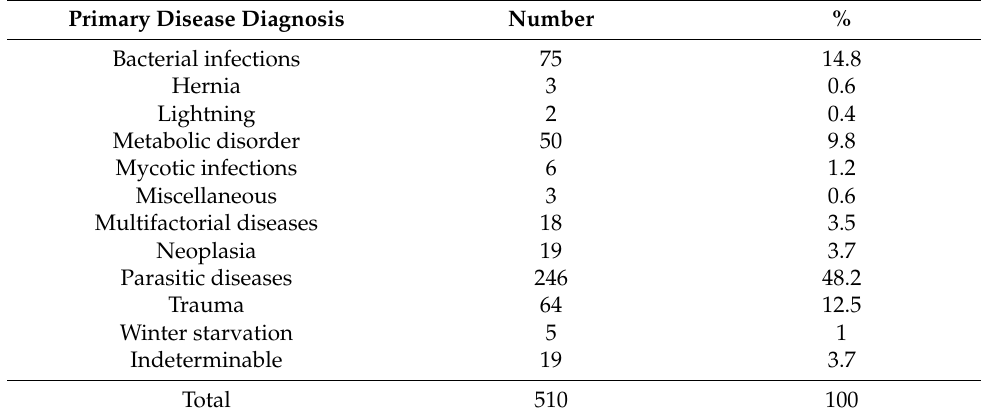
Table 1. Primary causes of mortality and morbidity in roe deer in Slovenia, 2000–2019.